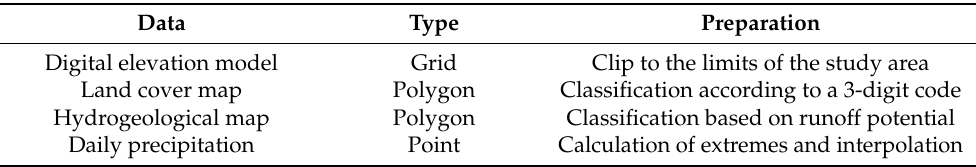
Table 1. Summary of datasets required to run the ArcDrain